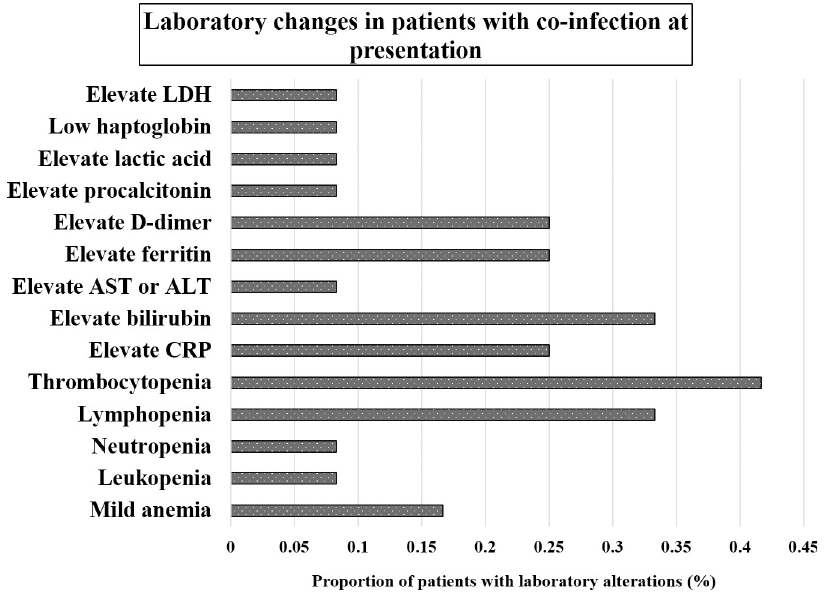
Fig 5. Laboratory alterations of patients with coinfection at